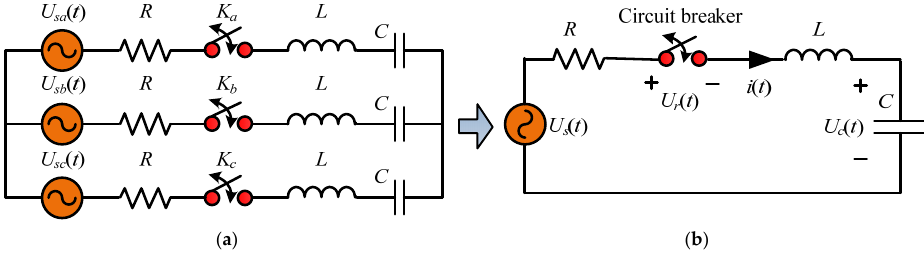
Figure 2. Circuit of switching shunt capacitor banks. ( a ) Symmetrical three ‐ phase circuit; and ( b ) reduced circuit.